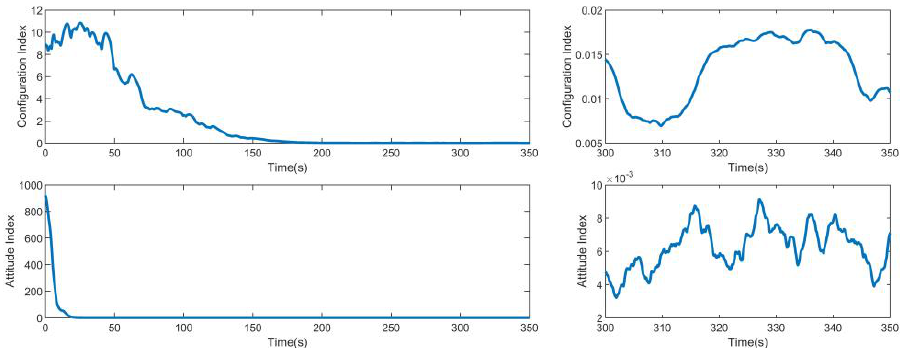
Figure 16. Configuration maintenance index and relative attitude index of consistent collaborative control for SAR satellite formation.